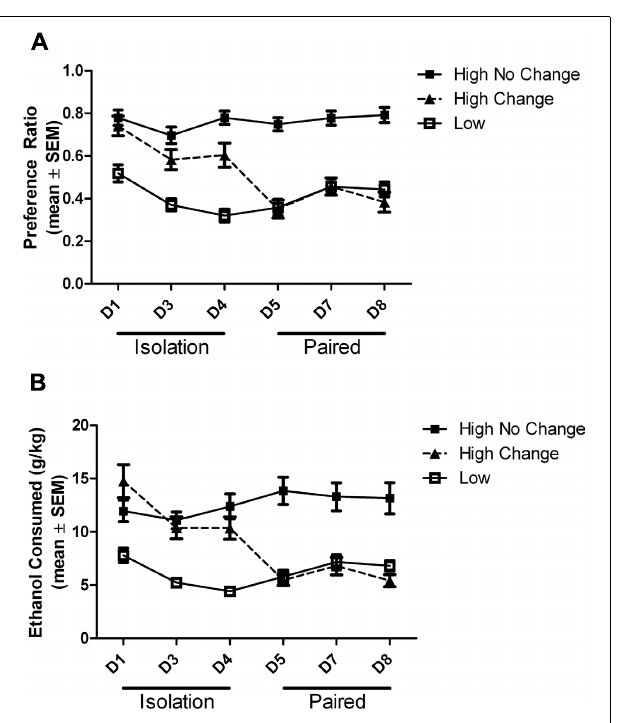
FIGURE 3 | Ethanol preference and intake across days. Ethanol preference (A) and intake (B) by high drinkers that did (black square) or did not (black triangle) change ethanol intake when paired with low drinkers (white square) is shown across days of isolation and pair housing. In isolation, both high groups are significantly higher than the low drinkers. During pair housing, the high drinkers that change intake and the low drinkers are both significantly lower than the constant high drinkers.